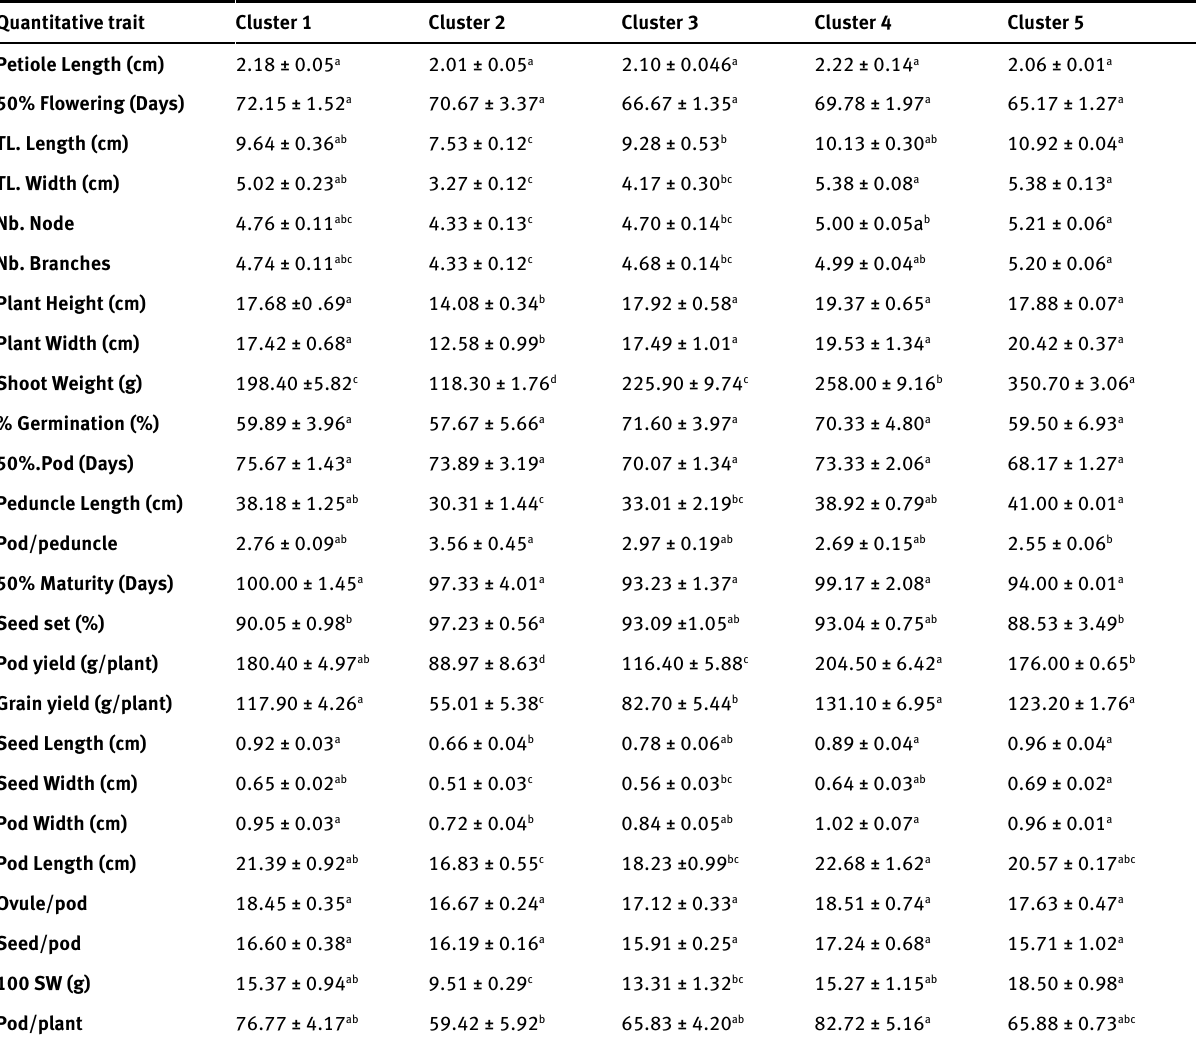
Table 7: Mean values of 25 quantitative traits for five groups revealed by cluster analysis on 30 cultivated Vigna unguiculata accessions Quantitative